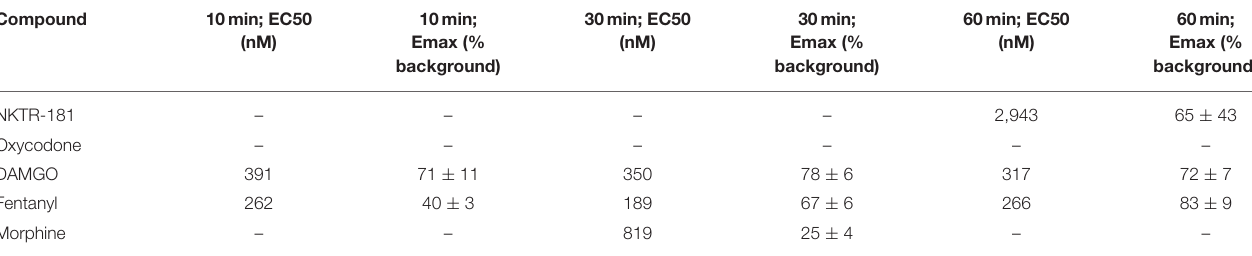
FIGURE 4 | NKTR-181 induces limited internalization. Internalization was assessed in HEK cells expressing FAP-labeled MOPrs and quantified by flow cytometry. (A) After 10min of agonist incubation at 37 ◦ C, DAMGO and fentanyl, but no other agonist, induced dose-dependent internalization. (B) After 30min of incubation, DAMGO, fentanyl, and morphine induced dose-dependent internalization. (C) After 60min of incubation, DAMGO, fentanyl, and NKTR-181 had induced dose-dependent internalization. Oxycodone did not induce dose-dependent MOPr internalization and could not be curve-fitted. The control samples indicated as a single broken black line, received vehicle at each of these timepoints. Data are shown as mean SEM. Refer to Supplementary Table 4 and Table 2 for statistics. ± TABLE 4 | The internalization profile of NKTR-181 compared with oxycodone and other MOPr agonists after increasing lengths of agonist incubation.